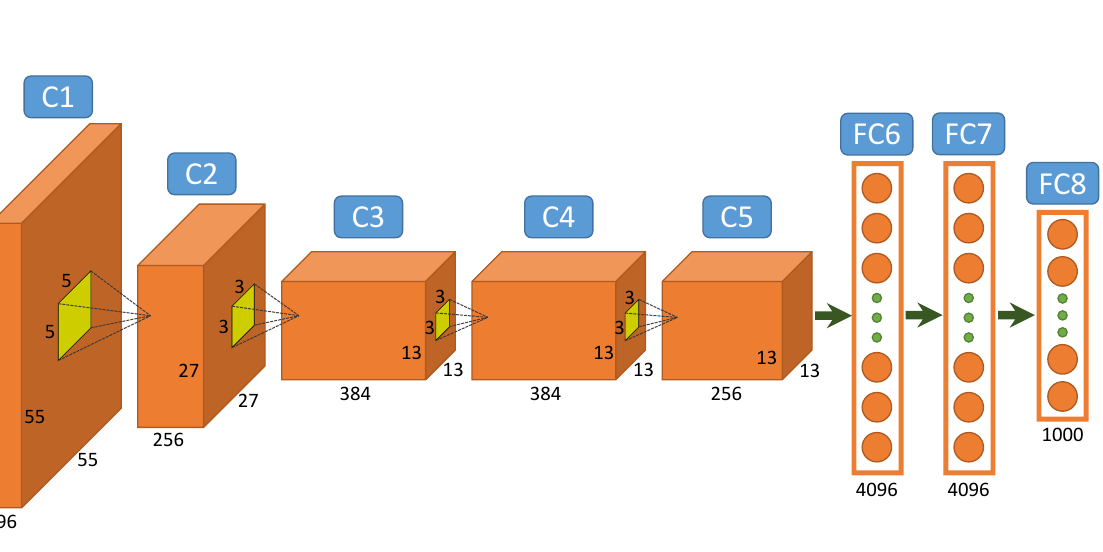
Figure 1. Illustration of a typical stage of a CNN. The convolutional layer is implemented by convolving the input with a set of filters, followed by a elementwise non-linear function (e.g., the ReLU non-linearity), and generates a group of feature maps, each of which corresponds to the response of convolution between the input and a filter. The pooling layer, if max-pooling used, outputs the maximal values of spatially successive local regions on the feature maps. Its main function is to reduce the spatial size of feature maps and hence to reduce computation for upper layers.